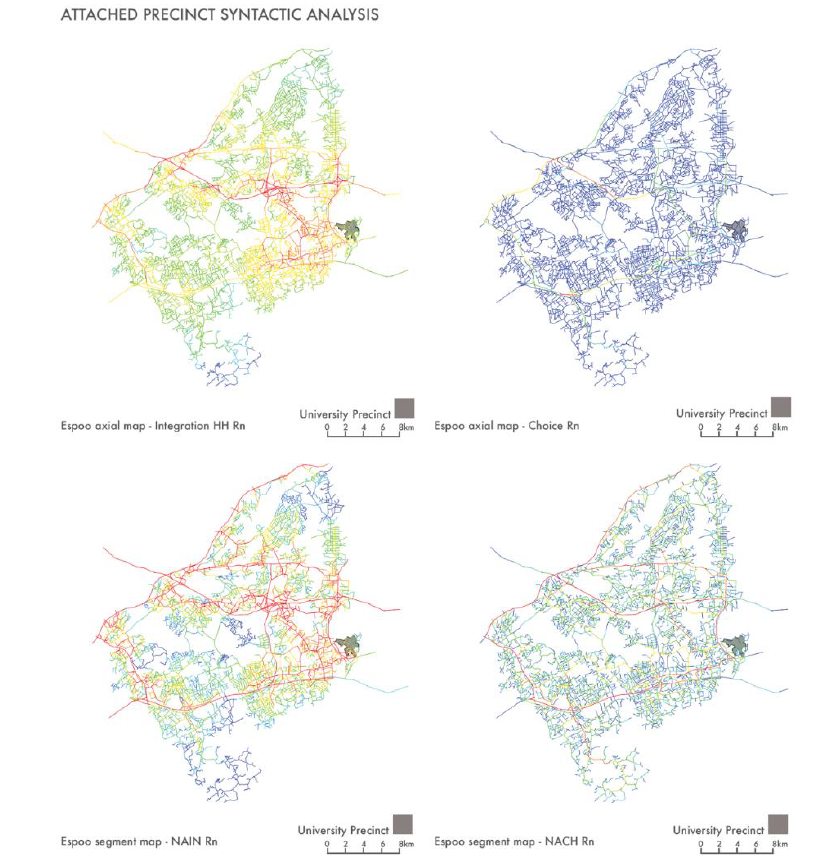
Figure 3 Espoo Axial and Segment Maps - Aalto University Campus Otaniemi